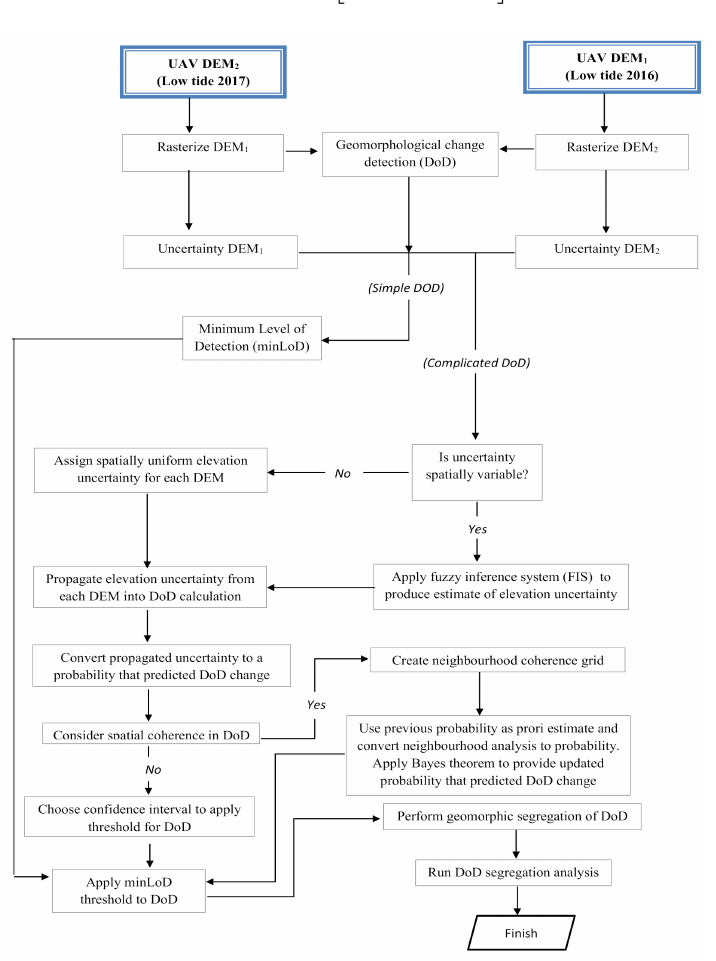
Figure 4. GCD workflow for the filtered DEM at low tide in 2016 and